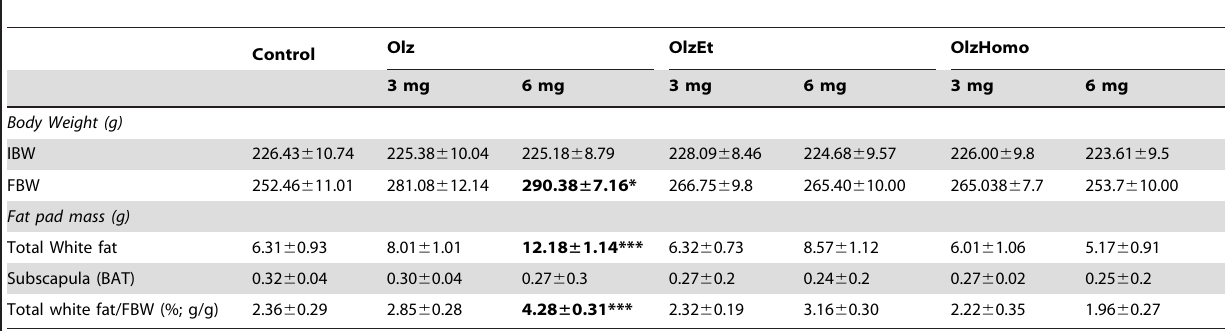
Mean body weight and fat pad mass in female Sprague Dawley rats following 5 weeks treatment with Olz, OlzEt, OlzHomo (3 mg/kg or 6 mg/kg), or vehicle (Control). IBW: initial body weight, FBW: final body weight. Data are expressed as mean 6 SEM, * P , 0.05, and. *** P , 0.001 vs . Control.